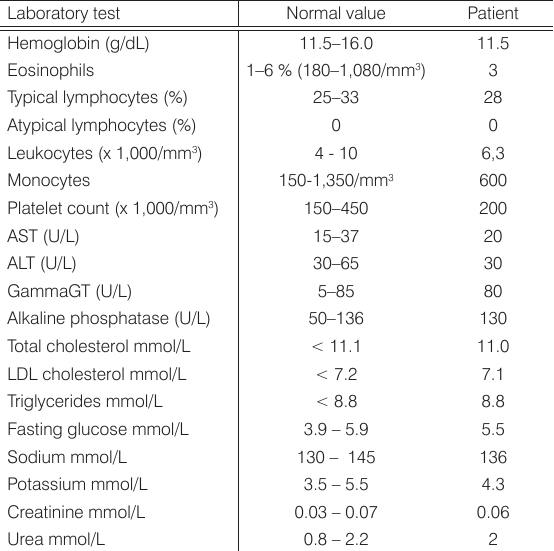
Table 1. Laboratory results on hospital admission.